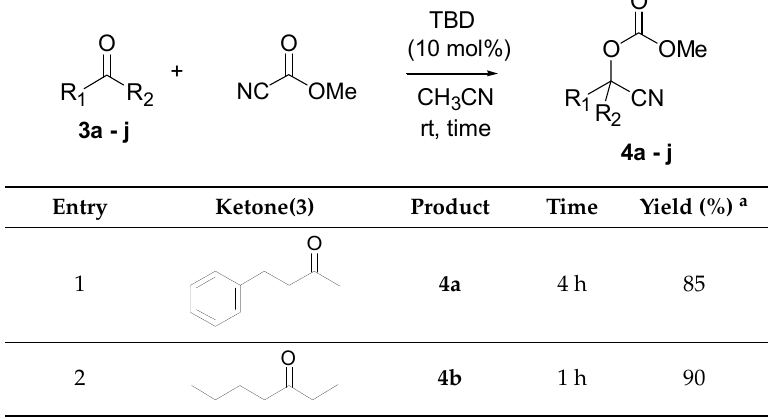
Table 2. TBD catalyzed cyanation of ketones with methyl cyanoformate. Table 2 TBD catalyzed cyanation of ketones with methyl cyanoformate.